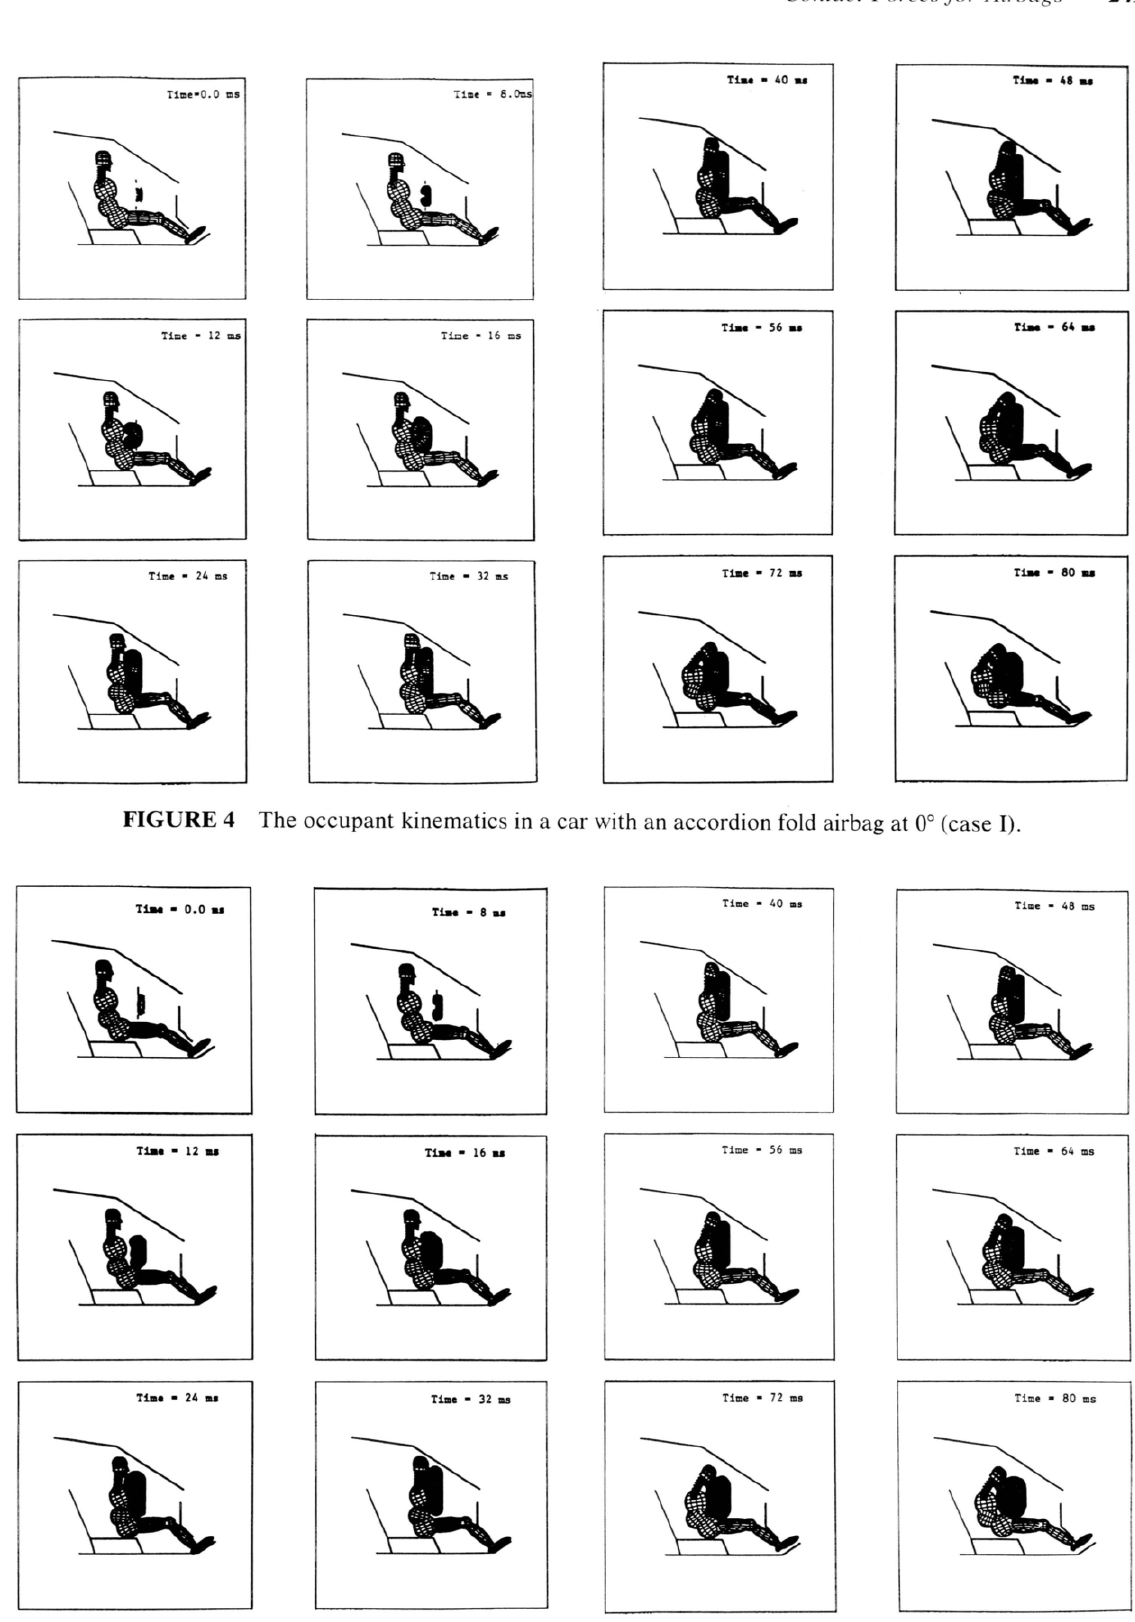
FIGURE 5 The occupant kinematics in a car with a pleated accordion fold airbag at 0° (case